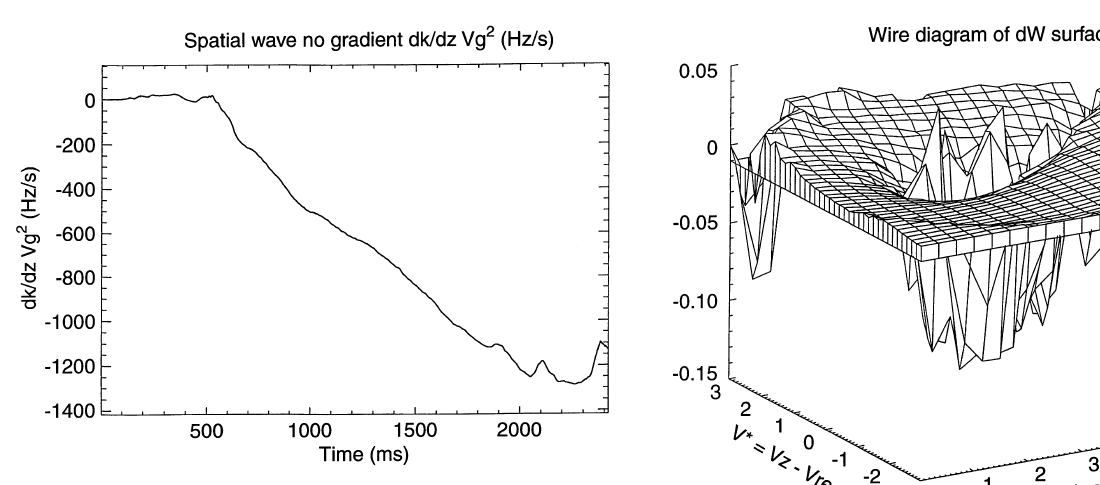
Fig. 12. Case B. Plot of spatial wave number gradient ( ) d k /d z . Vg 2 ) in Hz/s as a function of time. Its value steadily decreases to ) 1200 Hz/s